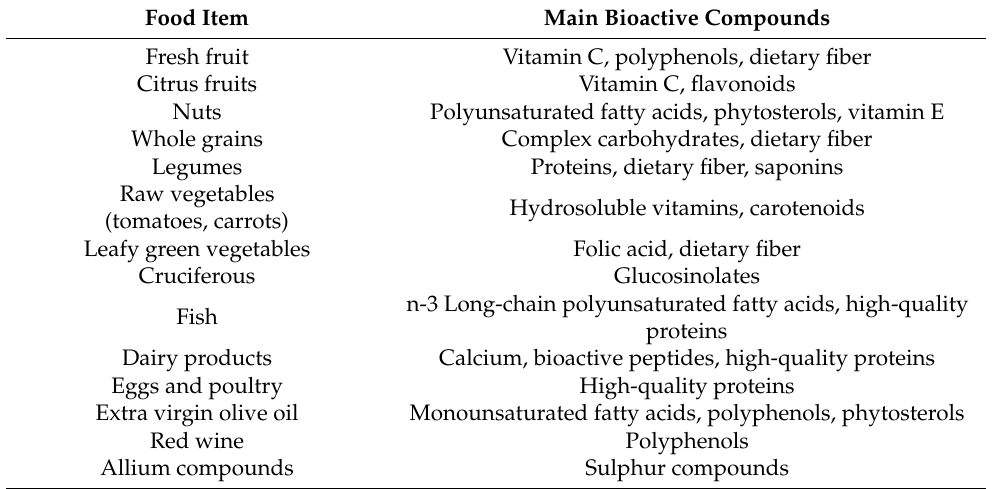
Table 1. Main bioactive compounds provided by representative foodstuffs of the Mediterranean